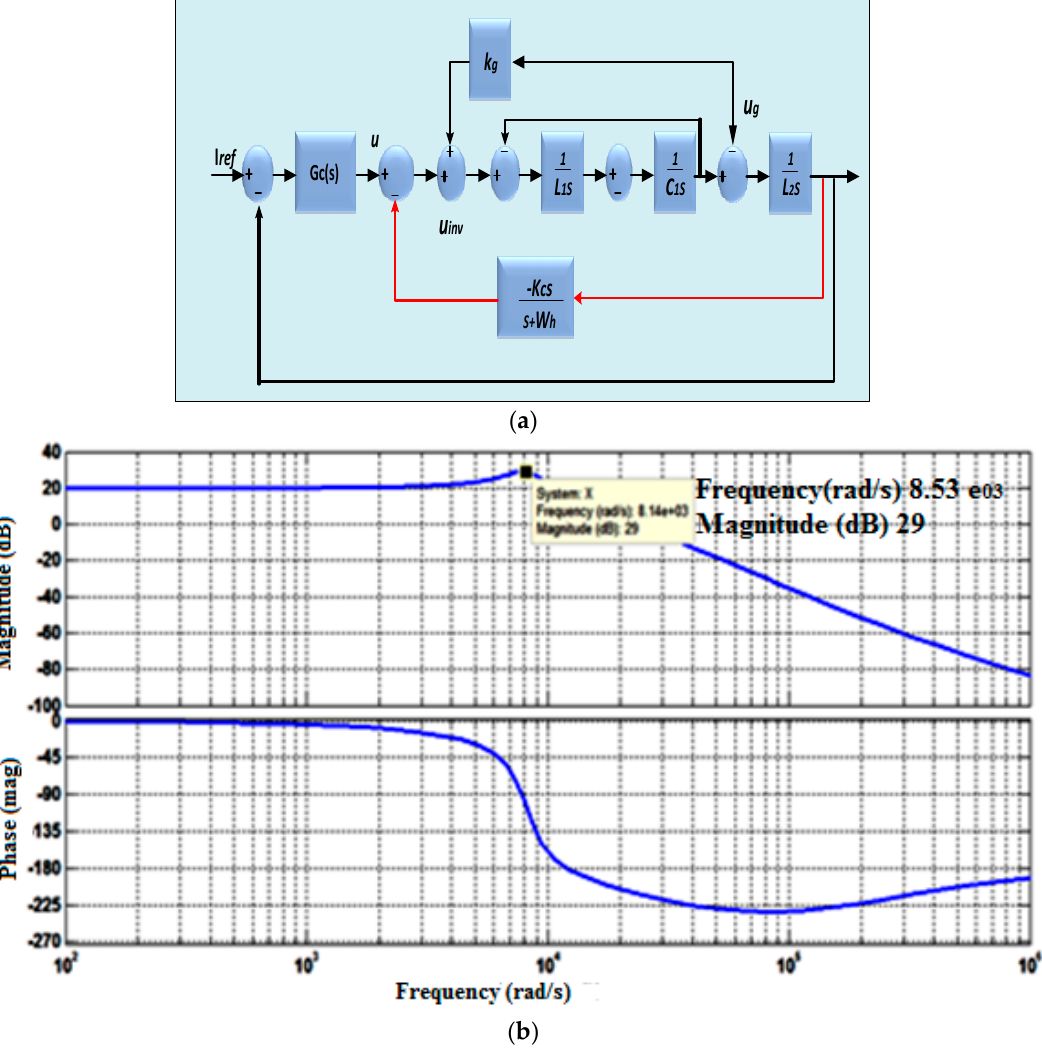
Figure 14. ( a ) Block diagram of grid injected feedback current controller. ( b ) Bode plot for grid injected current feedback controller with LCL filter.